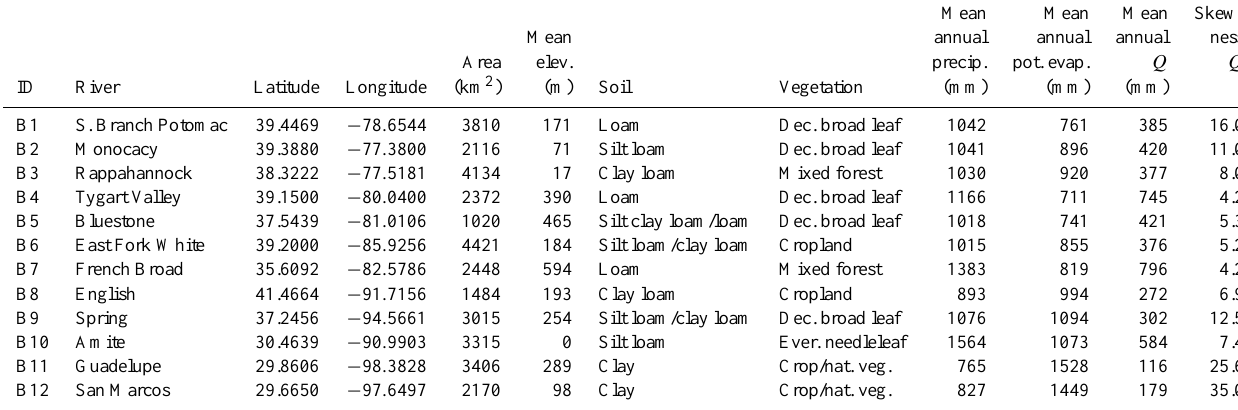
Table 1. Overview of MOPEX river basins and their